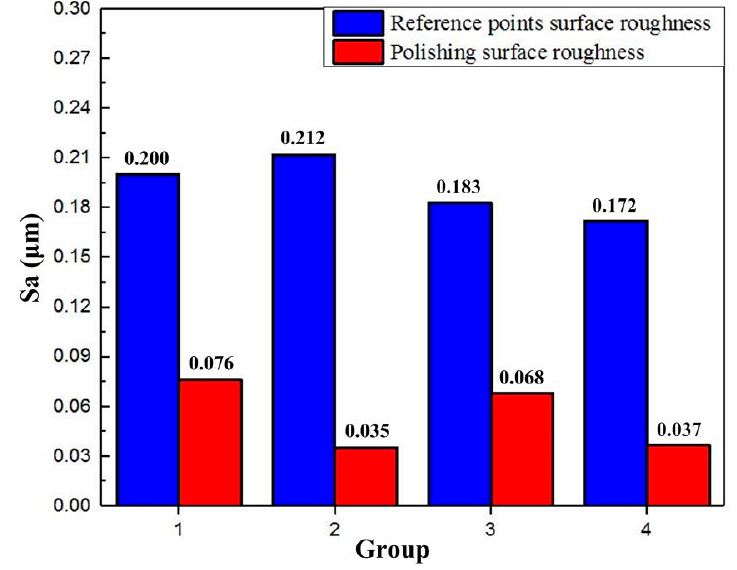
Figure 21. Data of average surface roughness (Sa) for polishing.